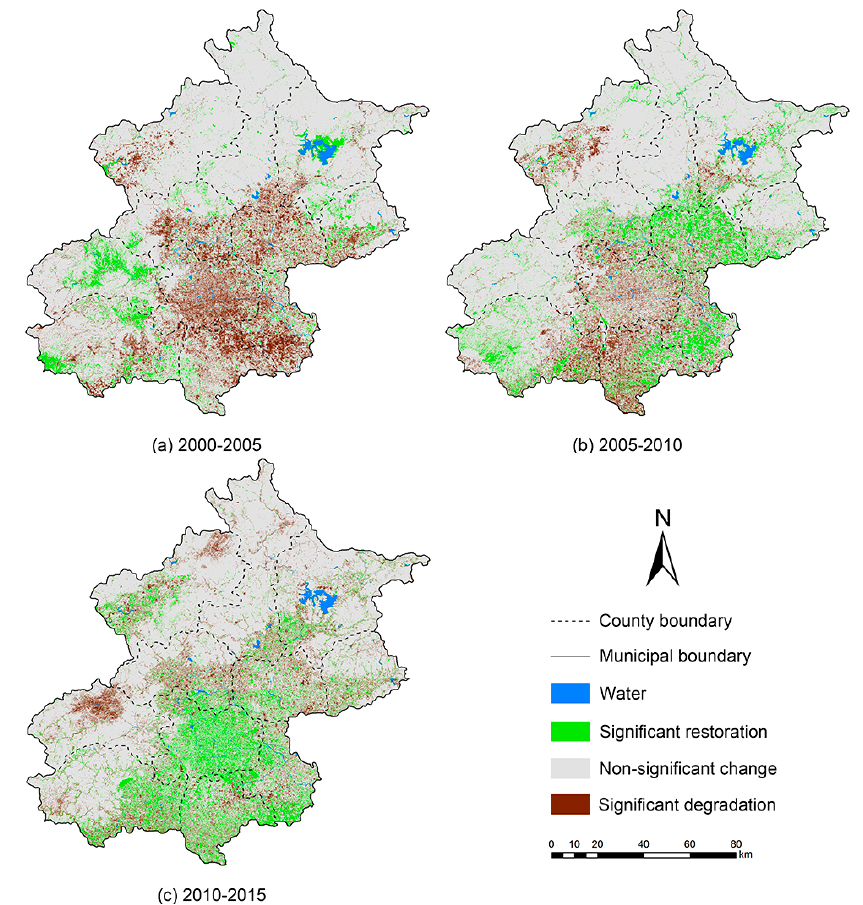
Figure 7. The spatial pattern of vegetation restoration and degradation in Beijing during ( a ) 2000–2005; ( b ) 2005–2010 and ( c ) 2010–2015.